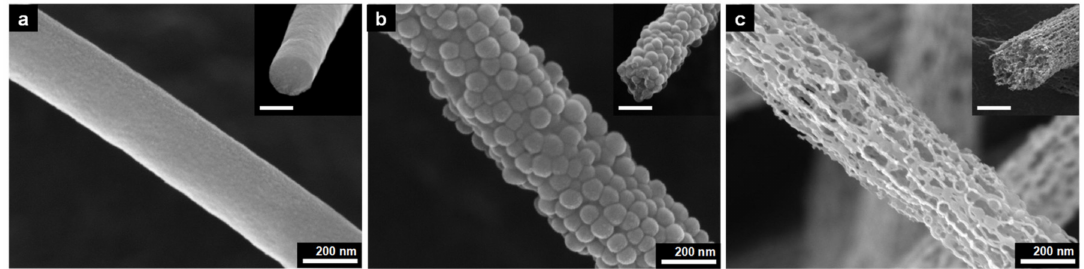
Figure 2. FE-SEM images of ( a ) neat CNF, ( b ) PAN / silica composite carbon nanofiber, and ( c ) p-CNF (insets: cross-sectional SEM images, scale bars = 200 nm).